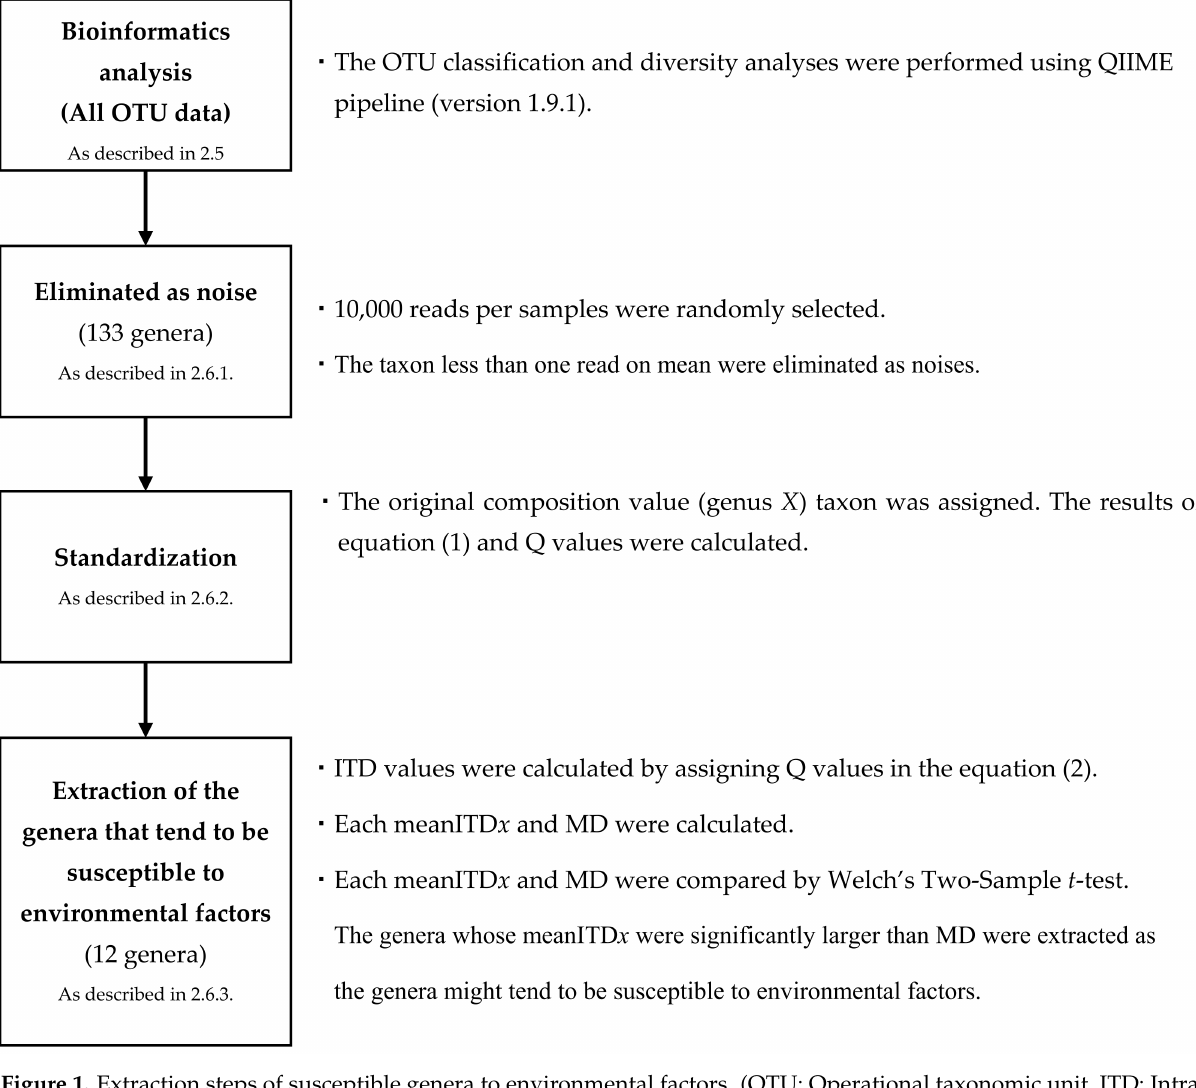
Figure 1. Extraction steps of susceptible genera to environmental factors. (OTU: Operational taxonomic unit, ITD: Intra- twins difference, mean ITD x : the mean ITD values of genus X for each of the 133 genera, MD: the mean of ITD values of 28 pairs for all 133